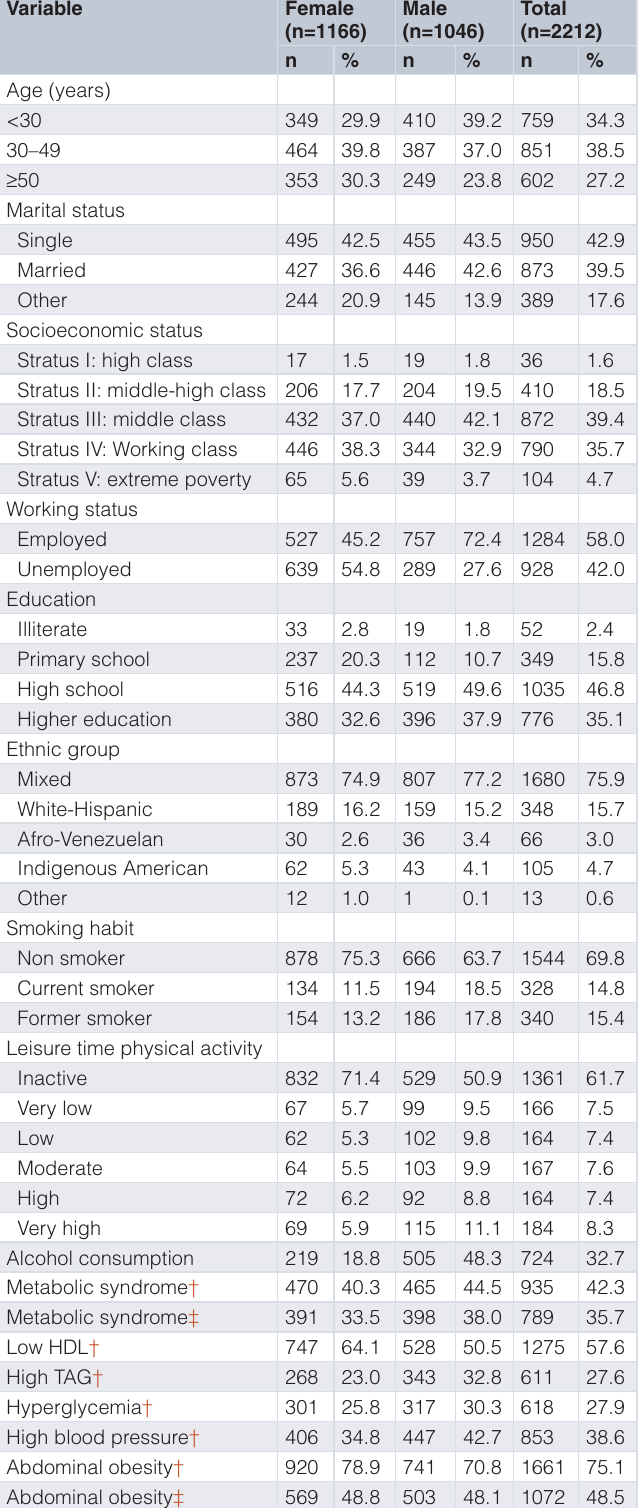
Table 1. General characteristics of the sample